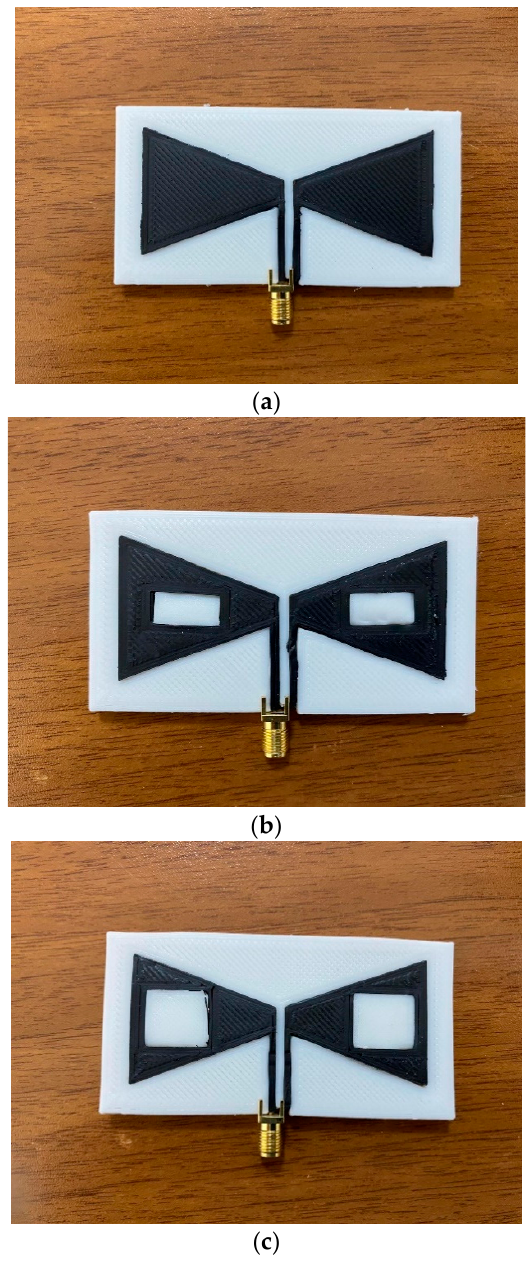
Figure 4. Fabricated bow-tie ( a ) Antenna-1, ( b ) Antenna-2, and ( c ) Antenna-3. An SMA connector is connected to the antenna’s terminals by heating and softening the graphene; see Figure 4. The connector’s positive pin is soldered to the right trian- gular patch that acts as a positive terminal, and the negative pin is soldered to the left triangular